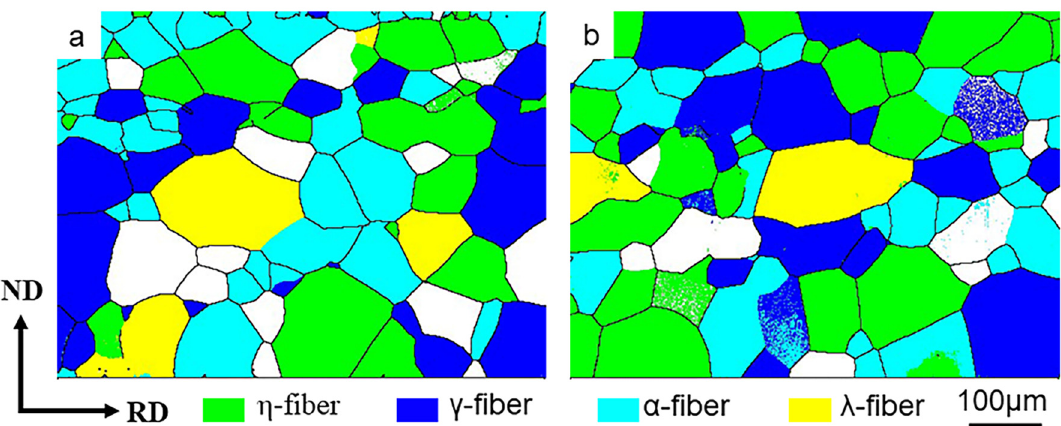
Figure 9. Four typical textures in symmetric-rolled ( a ) and asymmetric-rolled samples ( b ) after annealing at 850 °C.